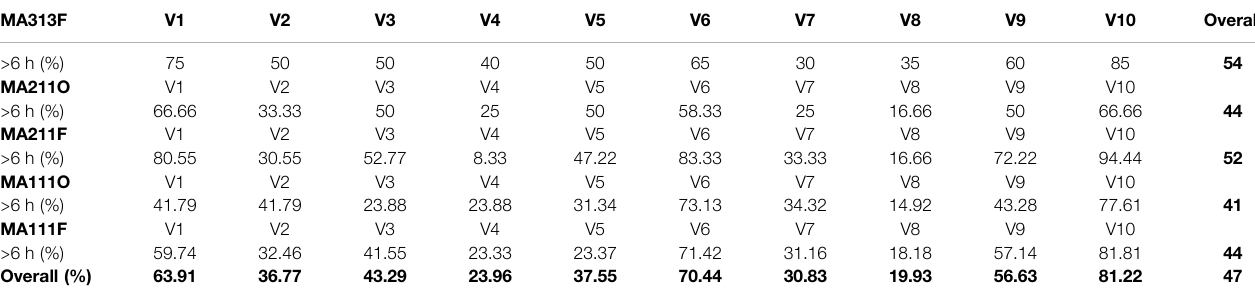
TABLE5| FrequencyoftheATsusedbythestudents.Thefrequencyisgreaterthan6asstudentsaccesstheATsforatleast1heachdaytocompletetheirtasks.Therefore, the minimum hours for this study is 6 h.